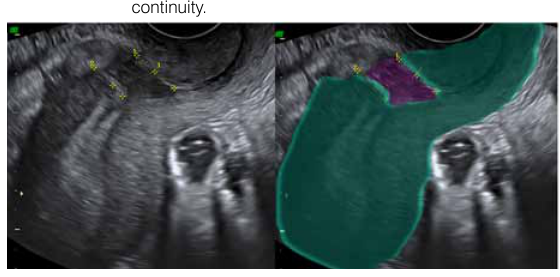
Figure 5. Complete dehiscense of the CS scar visualized 6 weeks after CS as a hypoechogenic loss of the myometrial